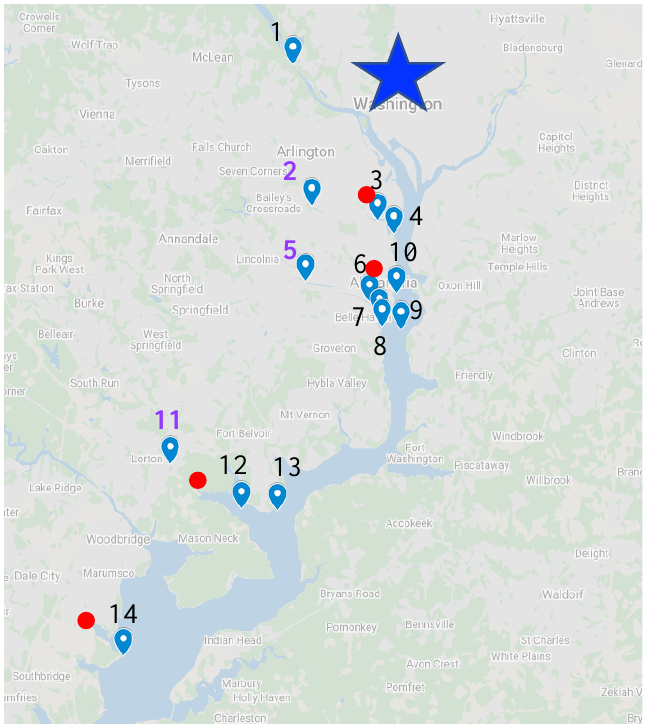
Figure 1. Sampling map of locations in the upland and tidal freshwater Potomac River watershed from Chain Bridge to Leesylvania State Park, VA. The city of Washington, D.C. is shown with a star. WTPs are shown as red dots and upstream reference sites are labeled with purple numbers on the map. Site names are 1, Potomac River at Chain Bridge; 2, Four Mile Run reference; 3, Four Mile Run near WTP; 4, Four Mile Run downstream; 5, Cameron Run reference; 6, Upper Hunting Creek near WTP; 7, Lower Hunting Creek downstream 1; 8, Lower Hunting Creek downstream 2; 9, Potomac River mainstem at Lower Hunting Creek; 10, Potomac River mainstem at Alexandria; 11, Pohick Creek reference; 12, Gunston Cove 1; 13, Potomac River mainstem at Gunston Cove; 14, Leesylvania State Park.